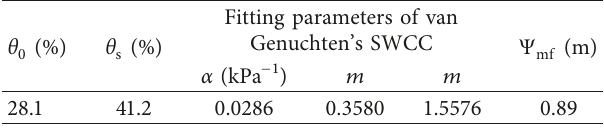
Table 4: Probabilistic rainfall intensity (mm/h) of the study area.